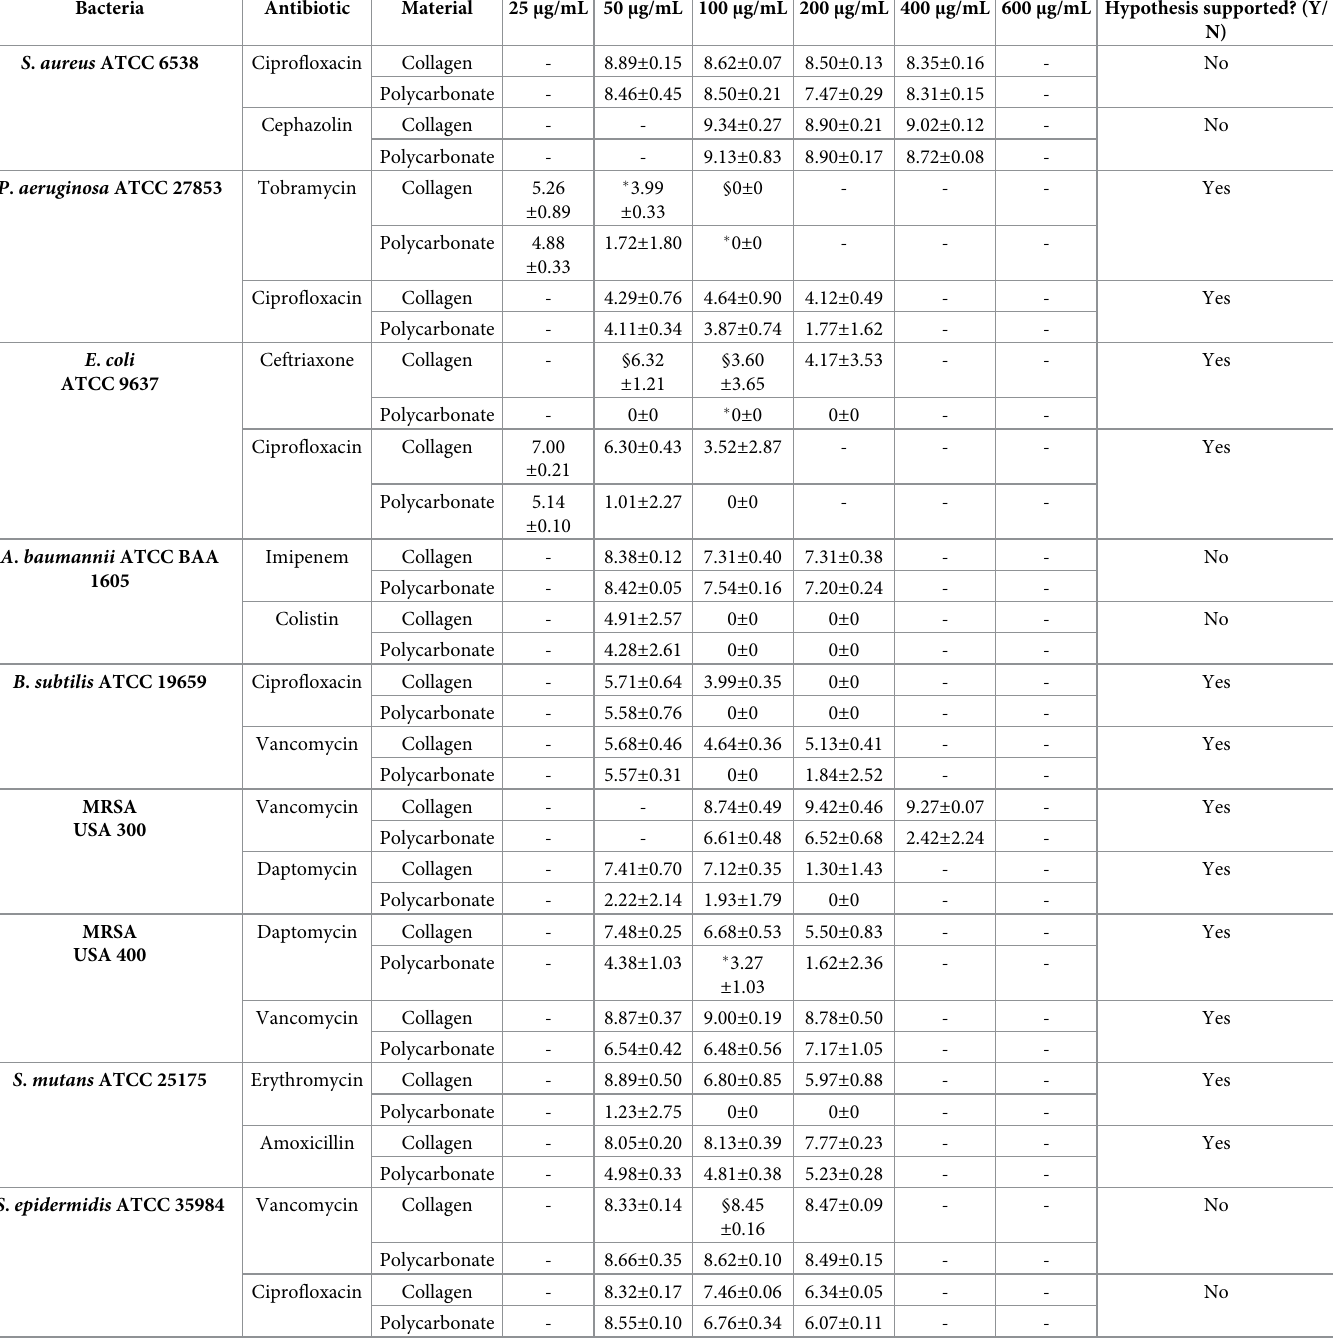
Table 3. Average of Log 10 transformed CFU/sample for each species and material at each concentration of antibiotic tested. Unless otherwise noted (at times cou- pons fell out of the rod in the reactor and were not included in analysis), n = 6 collagen coupons were analyzed and n = 5 polycarbonate coupons were analyzed. It was hypothesized that biofilms of varying species grown on a complex collagen network would be less susceptible to antibiotics as compared to biofilms grown on polycarbon- ate coupons. The criteria for support of the hypothesis was a difference of 1 log 10 unit or greater in bacterial counts between coupon types.